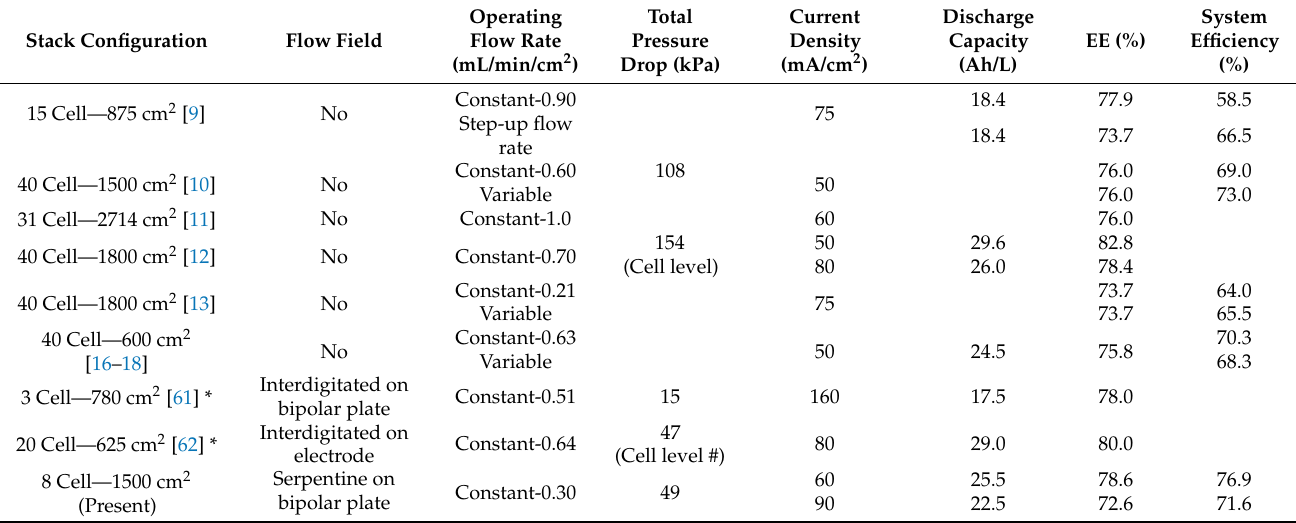
Table 6. Comparison of serpentine configured Vanadium redox flow battery (VRFB) stacks with that configured with conventional flow through mode and others. Stack